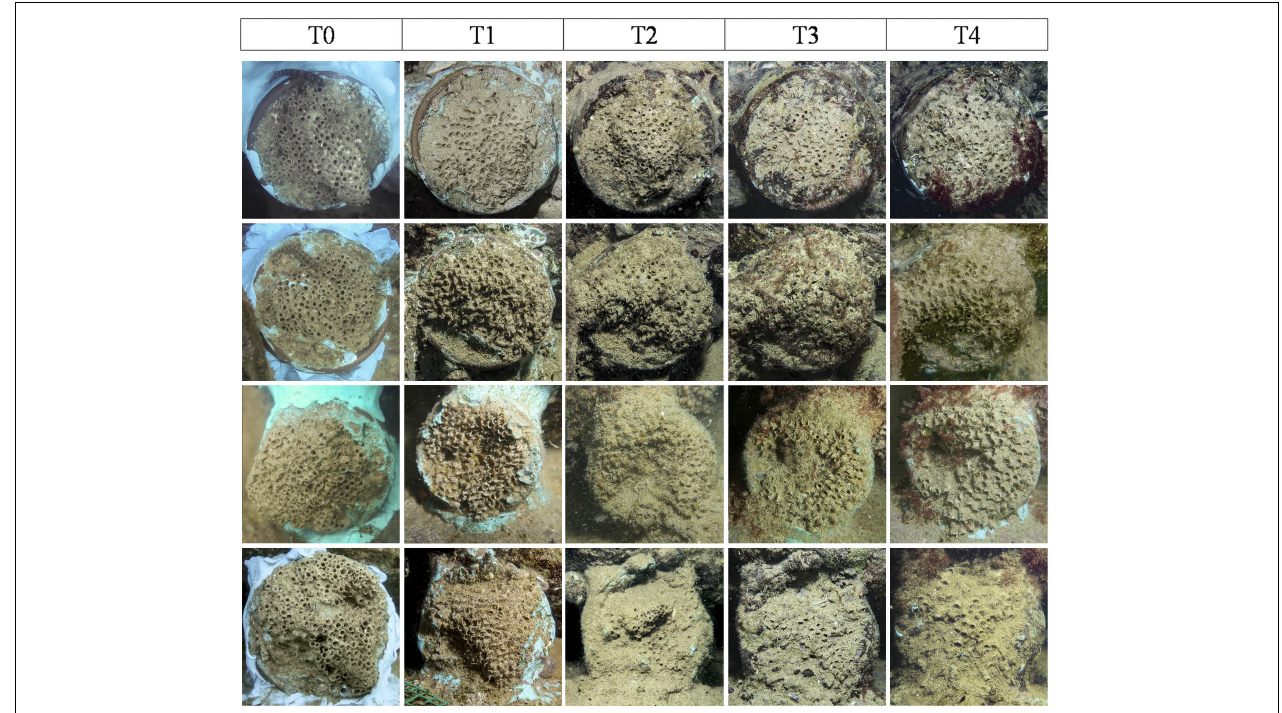
FIGURE 4 | Example of four translocation units monitored during the five experimental times (T0 = September, T1 = February, T2 = July, T3 = October, and T4 = February).